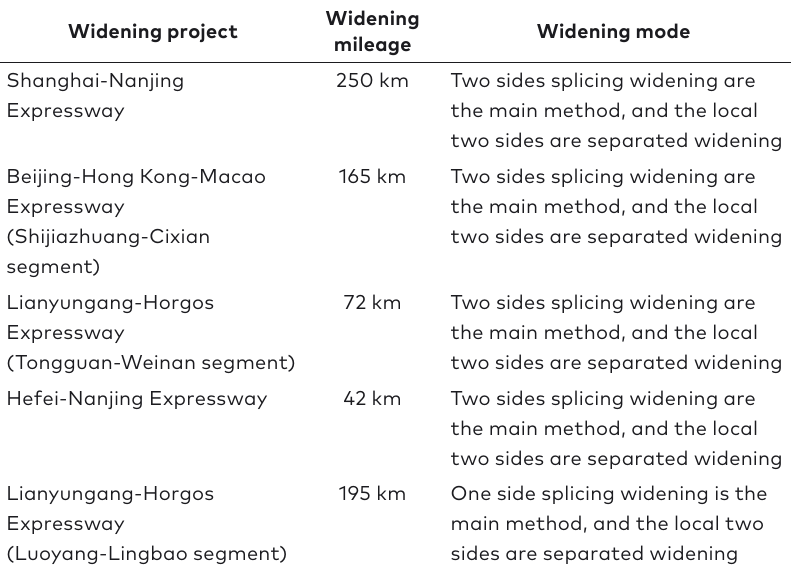
Table 1. Typical projects of subgrade separated widening in